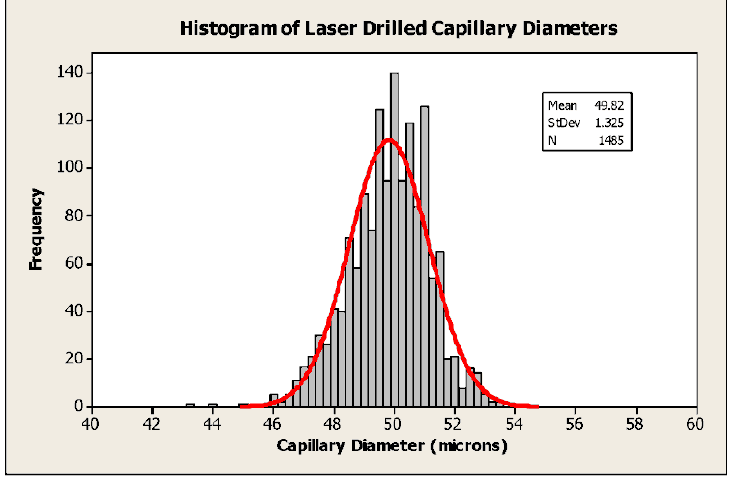
Figure 4. Sensor capillary diameters—typical reproducibility of development